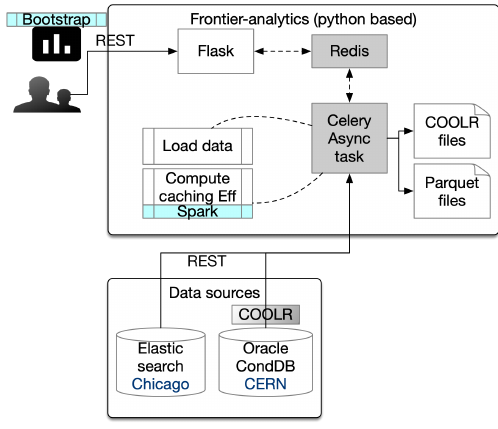
Figure 2. ATLAS Frontier Analytics